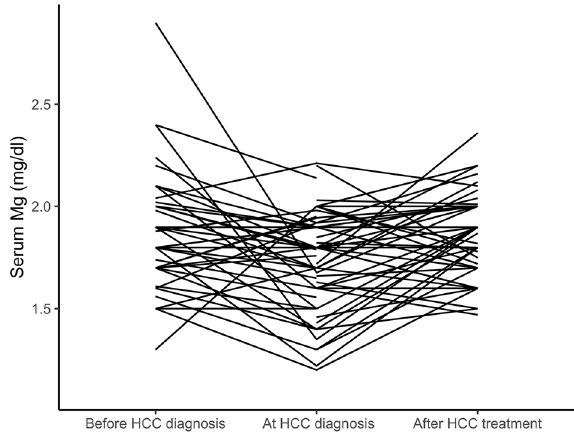
Figure 1. Spaghetti plot of serum Mg concentration in patients with HCC before tumor diagnosis, at the time of diagnosis and after locoregional